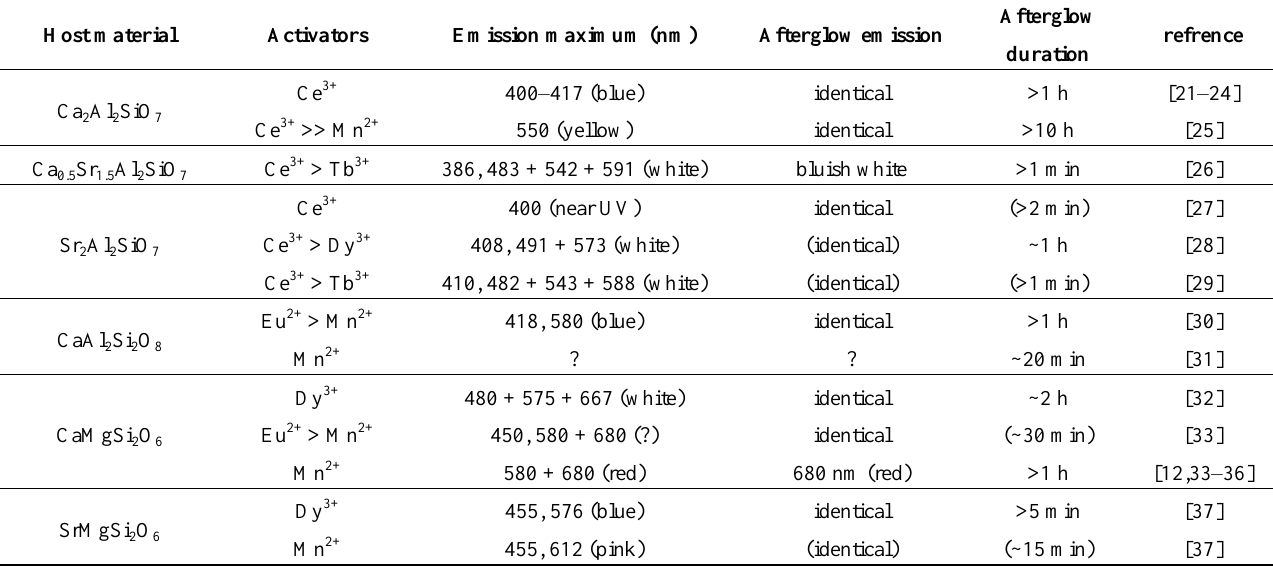
Table 1. Known non-Eu 2+ -based persistent luminescent silicates (STE = self-trapped exciton). Host